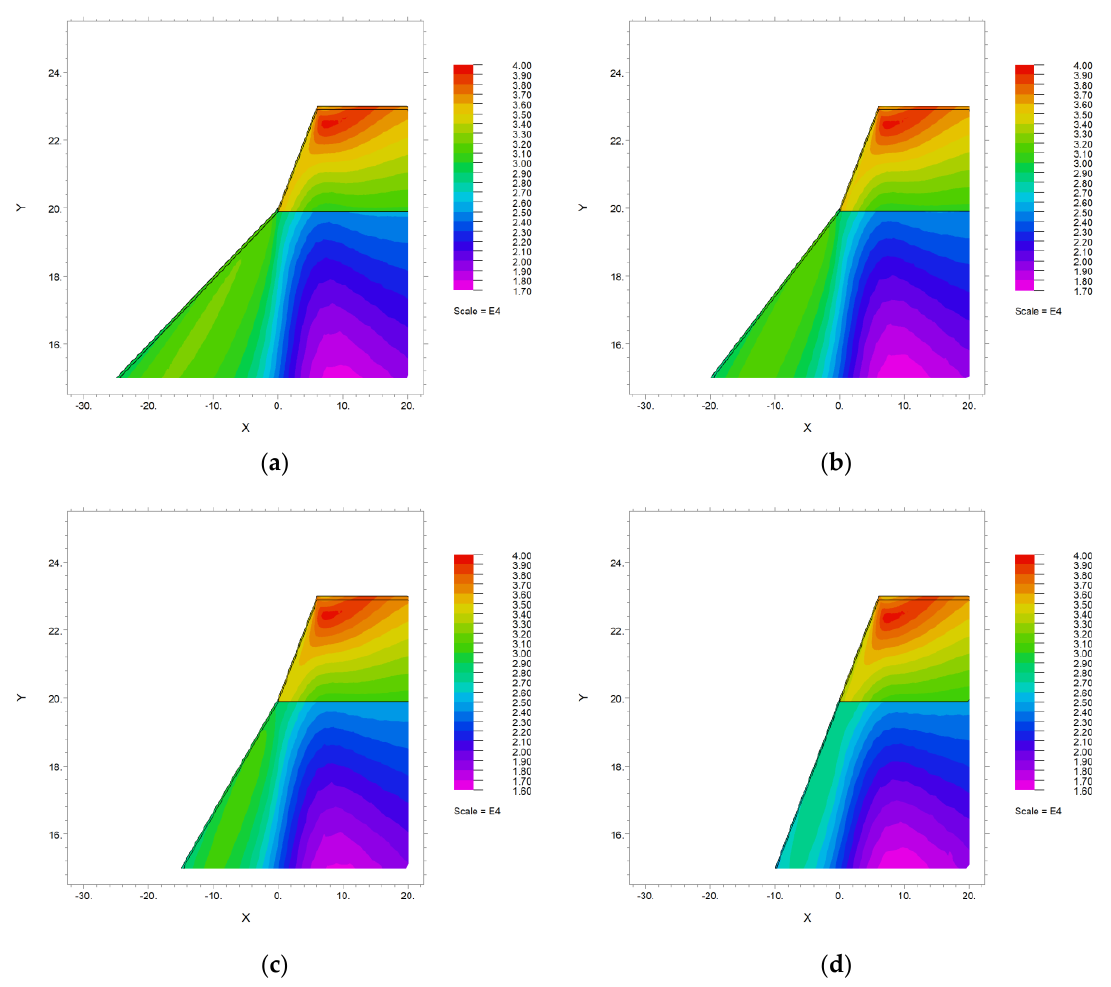
Figure 12. Coulomb – Mohr potential for the clay-type subsoil, for underwater slope inclinations of ( a ) 1:5, ( b ) 1:4, ( c ) 1:3, ( d ) 1:2 (negative values indicate compressive stresses in Pa, and positive values — tensile stresses in Pa).